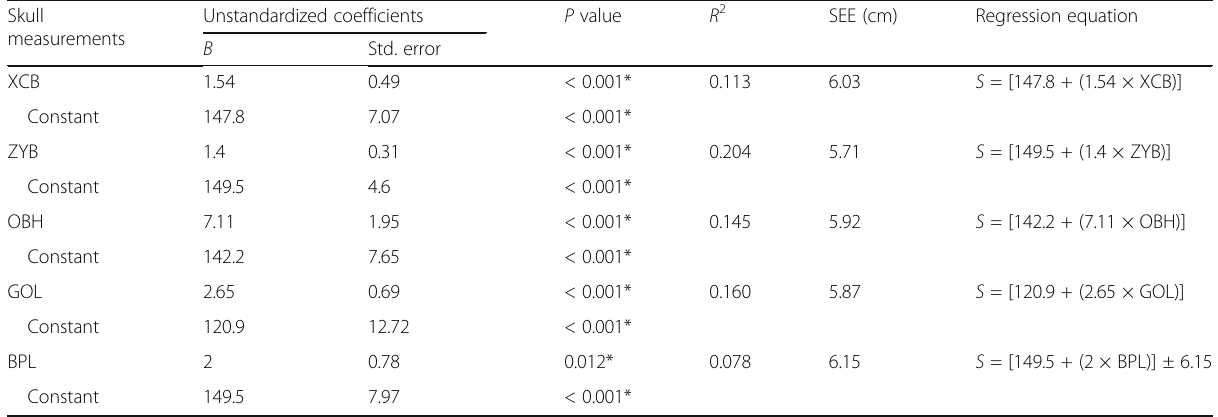
Table 6 Simple linear regression analysis to predict stature from skull measurements in males (N = 80) Skull measurements